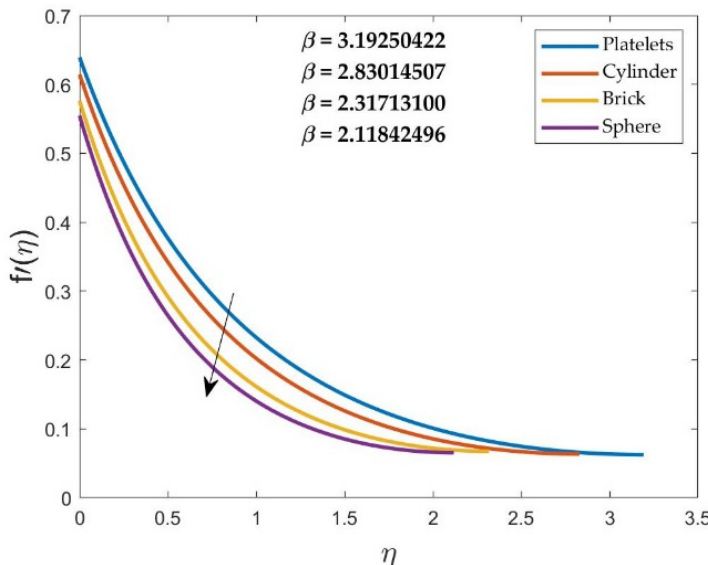
Figure 2. Impact of shape factor on velocity profile for 𝑆 = 0.4 , 𝑀 = 1.0 , 𝐾 = 0.5 and 𝜑 = 0.02 .